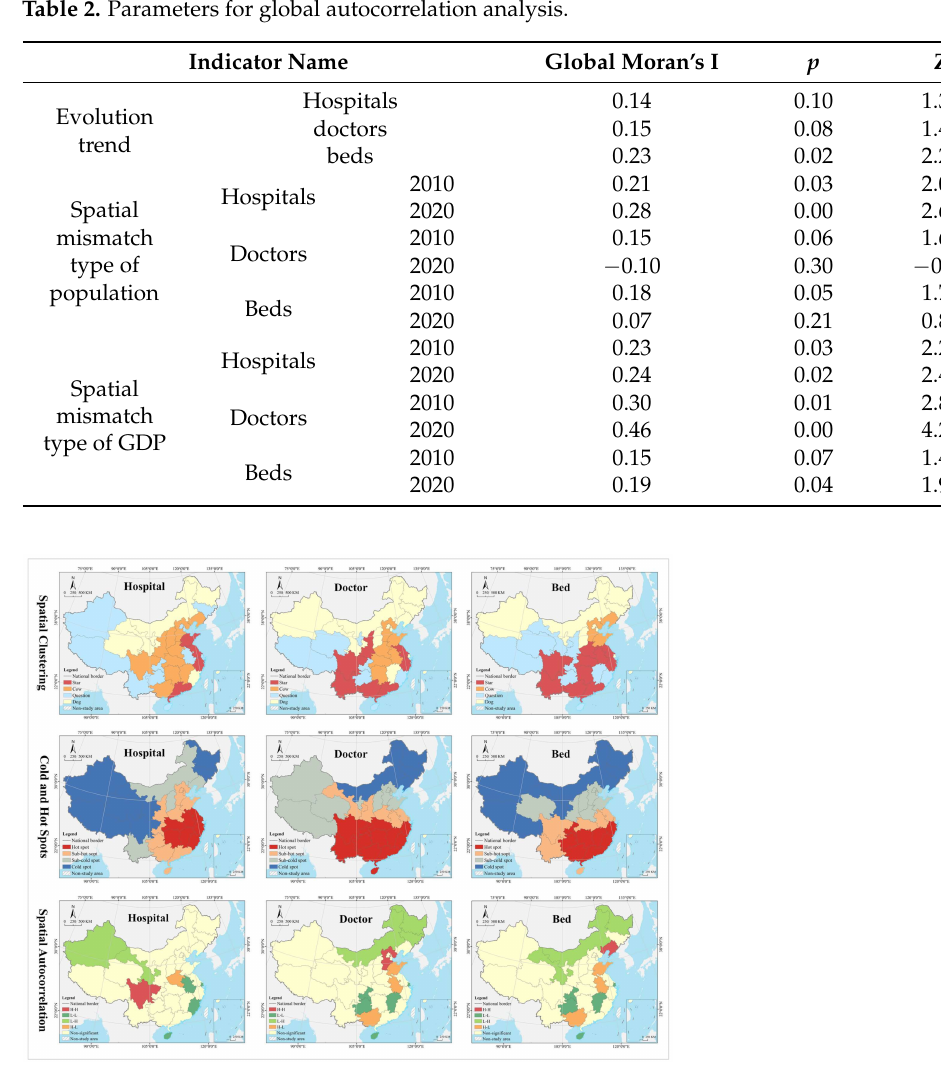
Figure 6. Spatial analysis of evolution